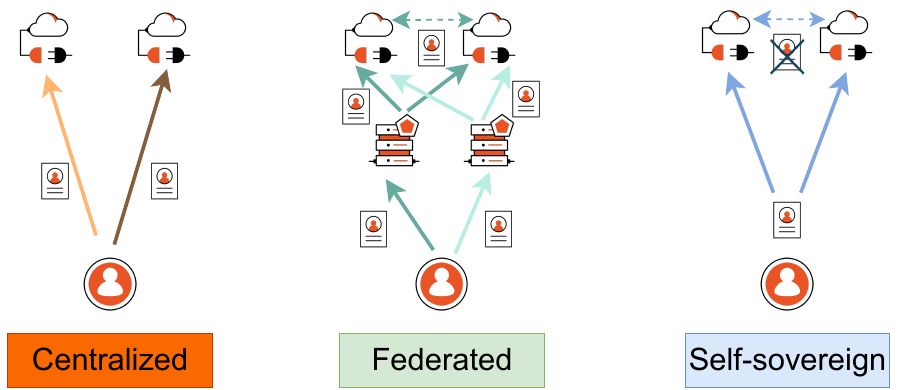
Figure 7. Comparison of different identity management